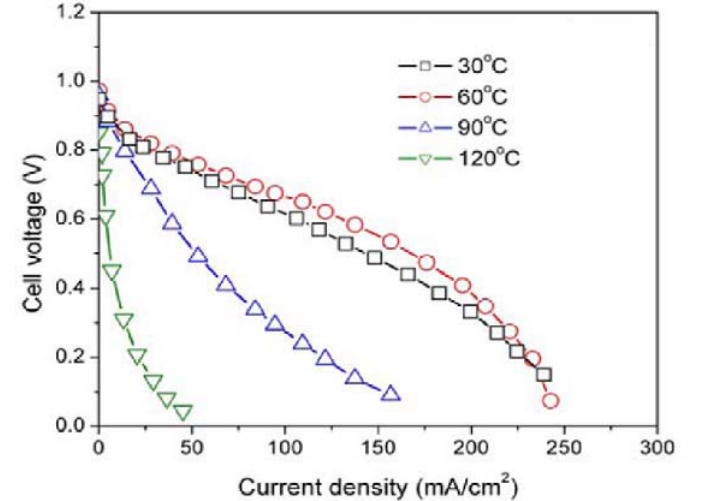
Figure 7. Cell performance of HSA-MEA anode at different temperatures.